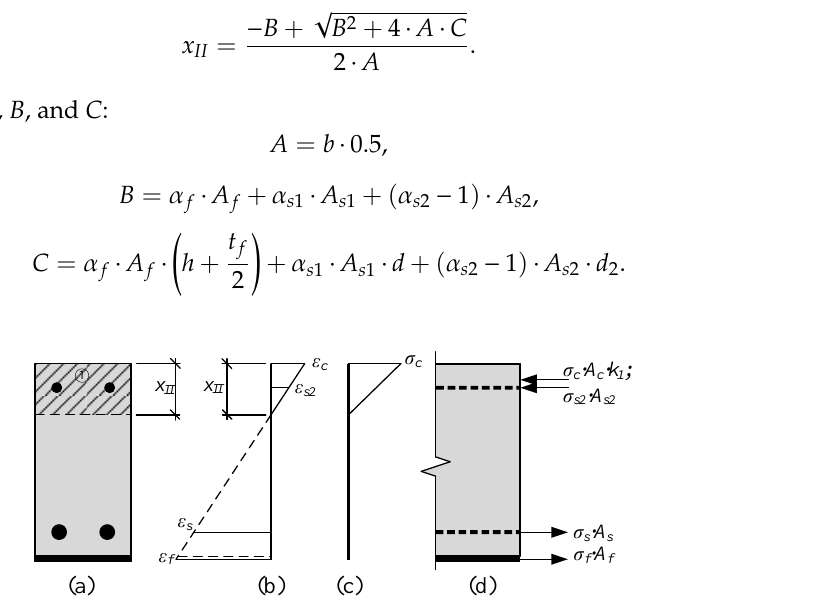
Figure 4. Stress-strain state in the strengthened RC beam until the yielding of reinforcement is reached: ( a ) Depth of the neutral axis; ( b ) distribution of strains; ( c ) distribution of stresses; ( d ) internal forces.